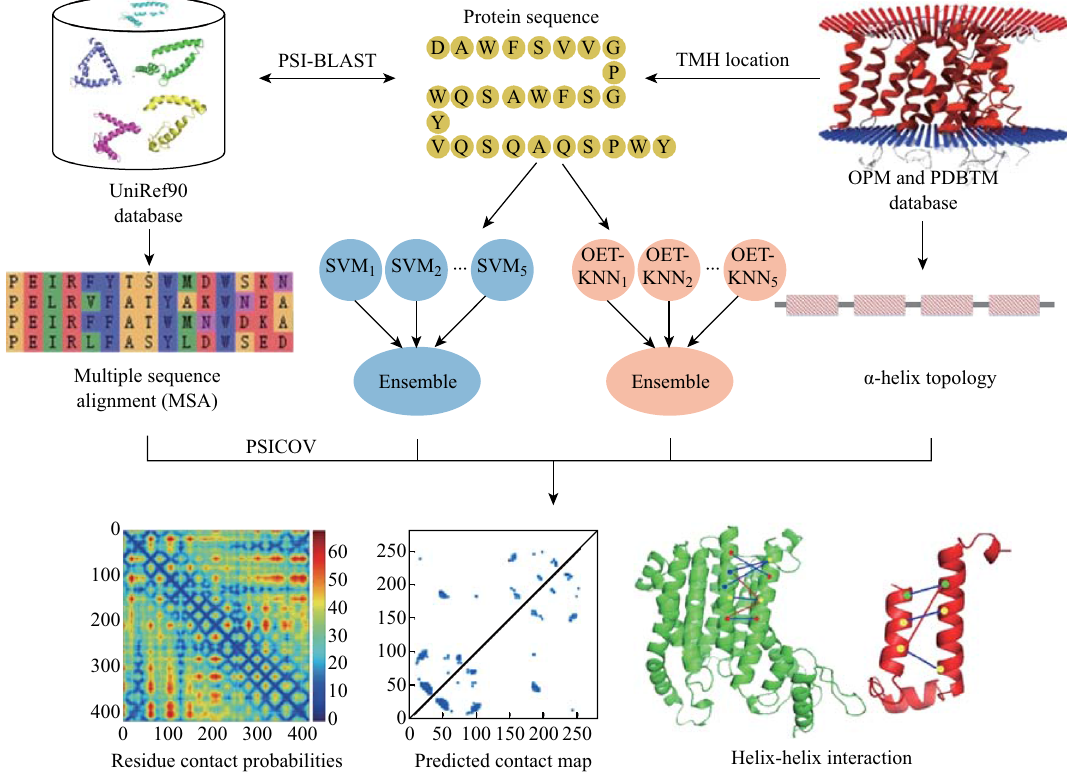
Fig. 4 The pipeline of MemBrain-Contact for predicting TMH–TMH contact map. We extract the TMH locations and topologies from protein database to build the training dataset. The coevolved mutation analysis by PSICOV using multiple sequence alignment generated by PSI-BLAST and machine learning-based algorithm outputs are combined to generate the final